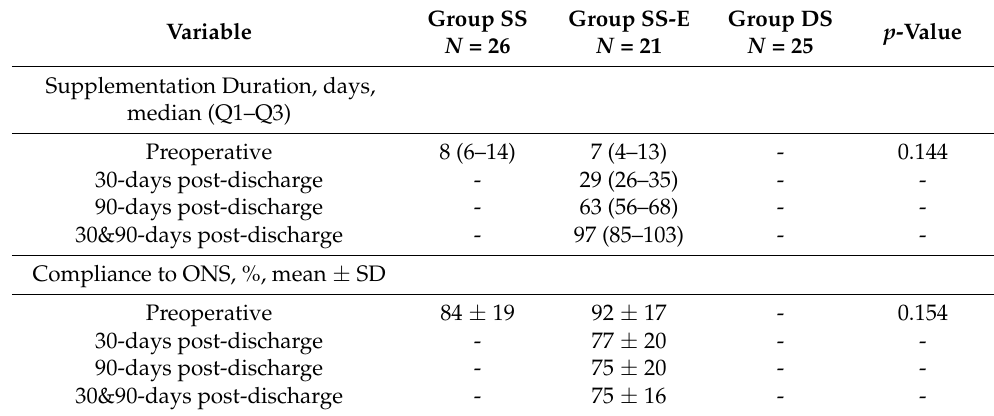
Table 2. Supplementation duration and compliance of